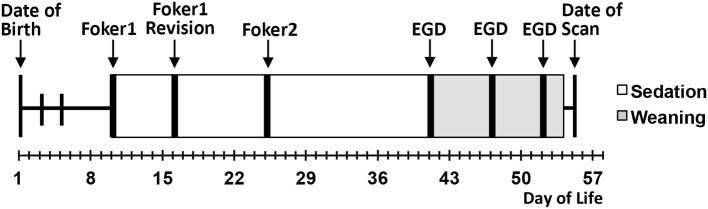
Schematic illustrates a single representative case of thoracic non-cardiac surgical [Foker process (21, 22)] and critical care treatment timeline for long-gap esophageal atresia (LGEA) repair that includes prolonged sedation to maintain mechanical ventilation (white boxes), as well as subsequent weaning of sedation drugs (gray boxes). Research brain MRI scan was done after completion of all treatment. EGD, esophagoduodenoscopy.